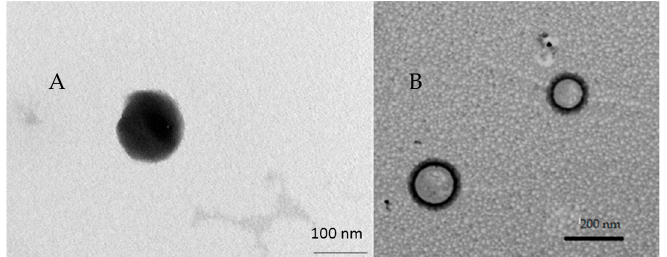
Figure 1. ( A ) Transmission electron microscope (TEM) image of TQ-loaded liposomes (LP-TQ); ( B ) TEM image of TQ-loaded liposomes coated with HA (LP-TQ-HA).